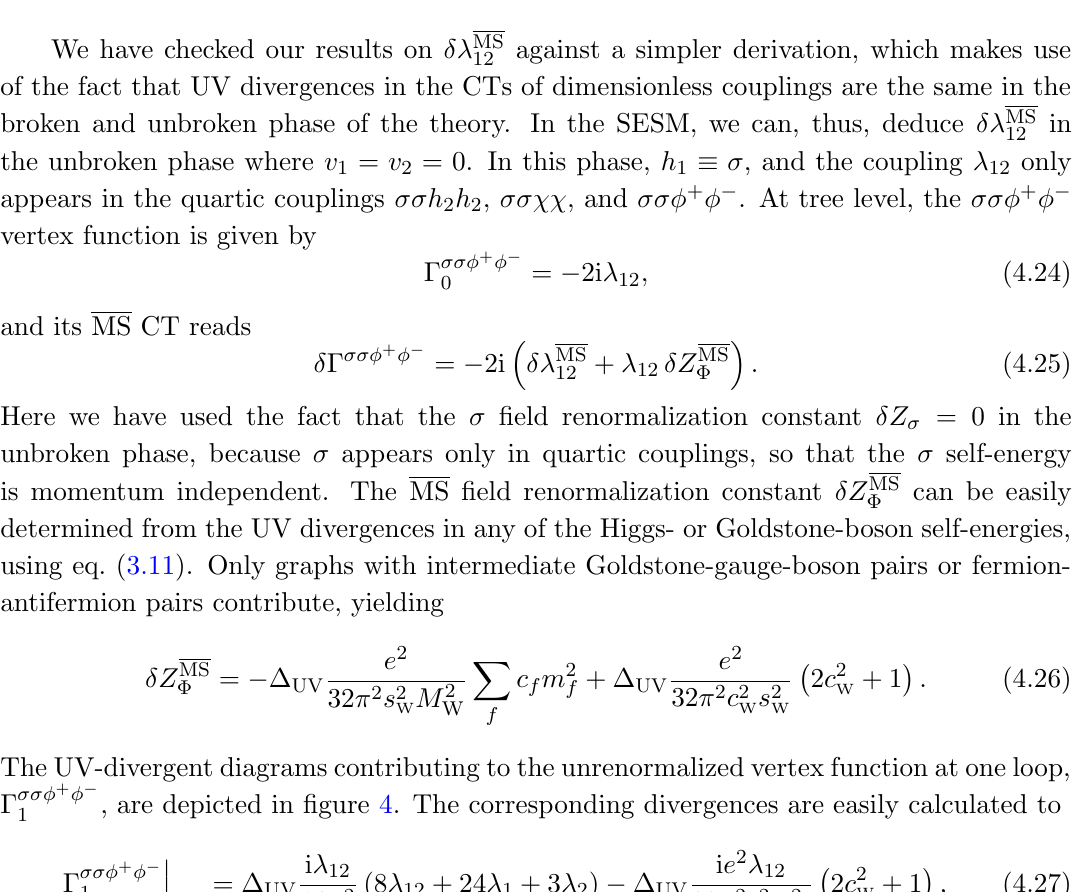
Figure 3 . Diagram types contributing to the hhh vertex used for the renormalization of (cid:21) 12